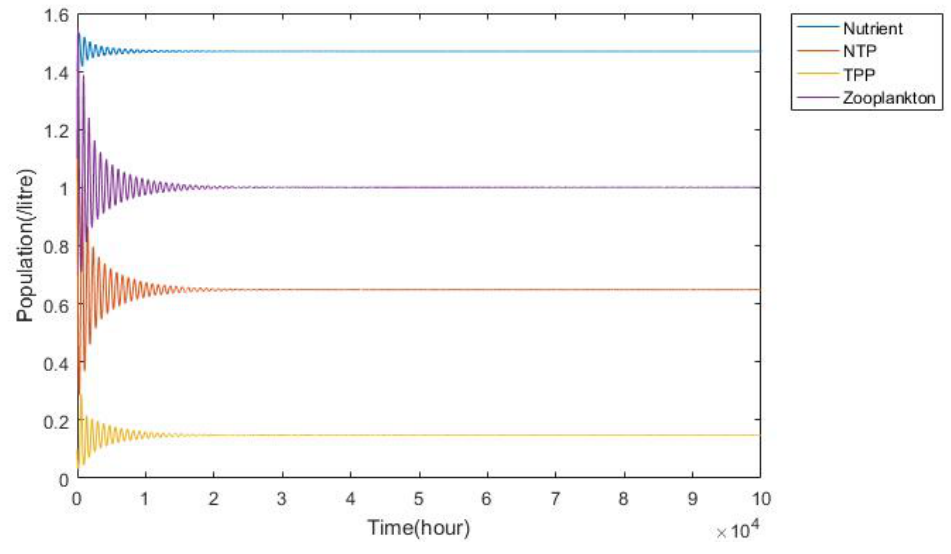
Figure 7. Simulation results of System (2) with τ = 30 > τ 0